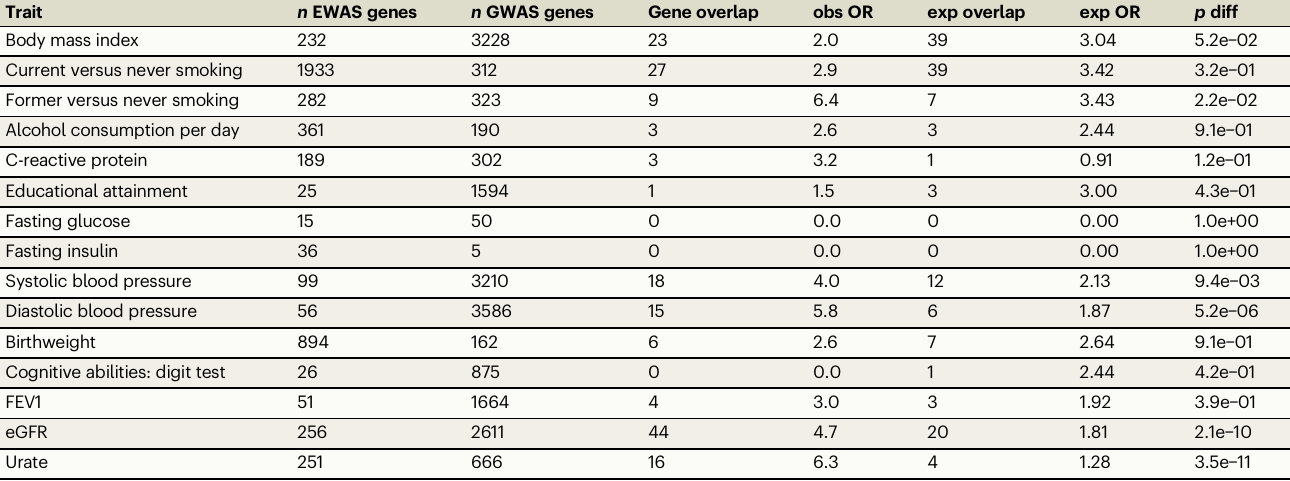
Table 2 | Overlap of genes identi fi ed by EWAS and GWAS Trait n EWAS genes